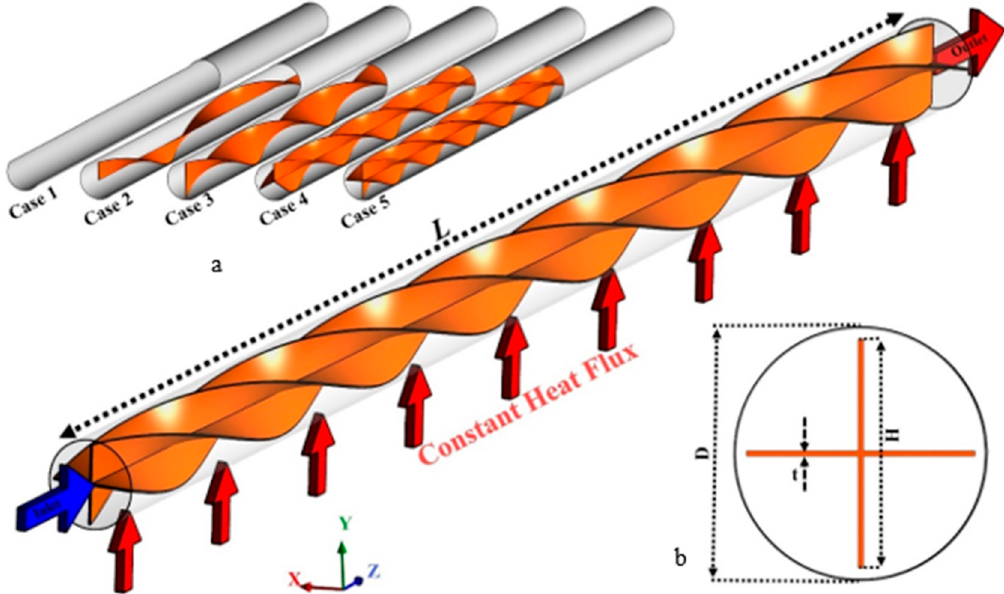
Figure 1. Schematic of the studied system using multiple semi-twisted tape inserts. ( a ) different proposed cases, ( b ) Bound- ary conditions and dimensions of the studied system